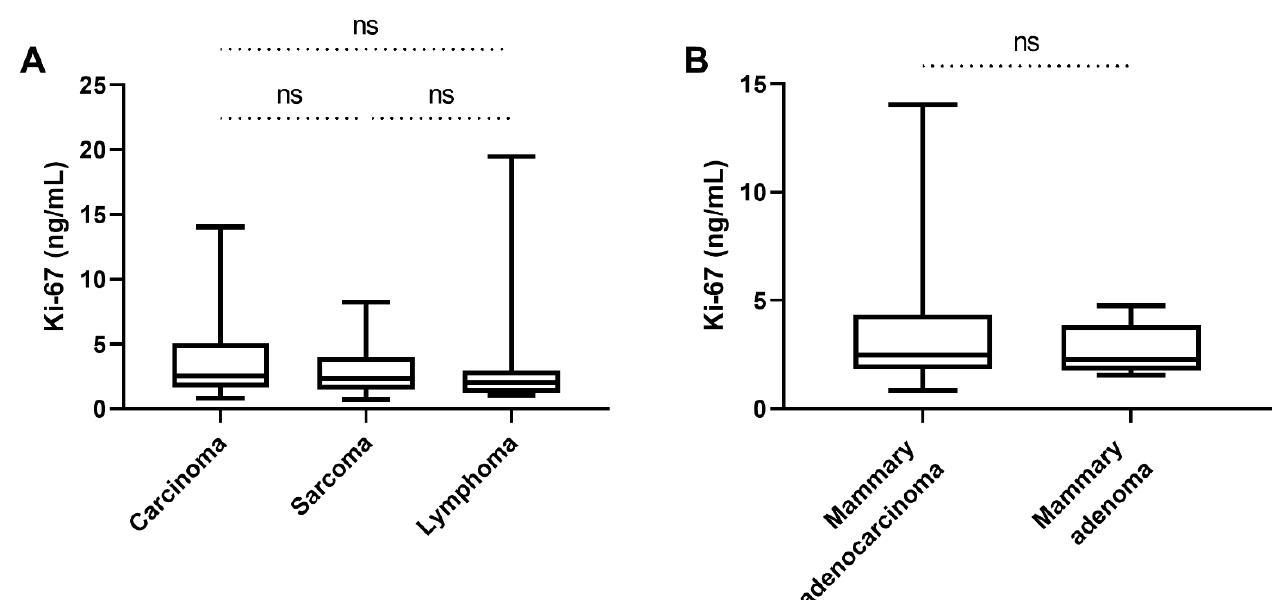
Figure 3. Serum Ki-67 concentrations within the group of dogs with tumour diseases. ( A ) Comparison of the serum Ki-67 concentrations of the different malignant tumour groups (epithelial tumours, mesenchymal tumours, and lymphoma). No significant difference could be found comparing these 3 groups of tumours ( p = 0.37). ( B ) When comparing the serum Ki-67 concentrations of dogs with mammary adenocarcinoma with those of the dogs with mammary adenoma, the tumour serum Ki-67 concentrations did not differ significantly ( p = 0.42). (ns) not significant.